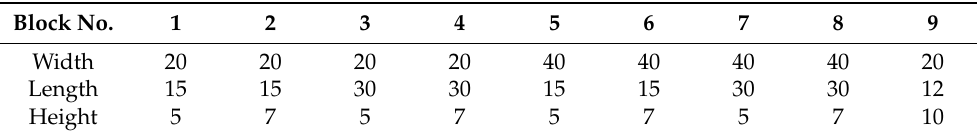
Figure 7. Assembled mock debris blocks for the smart cup test (unit in mm). Table 2. Debris block feature size chart (unit in